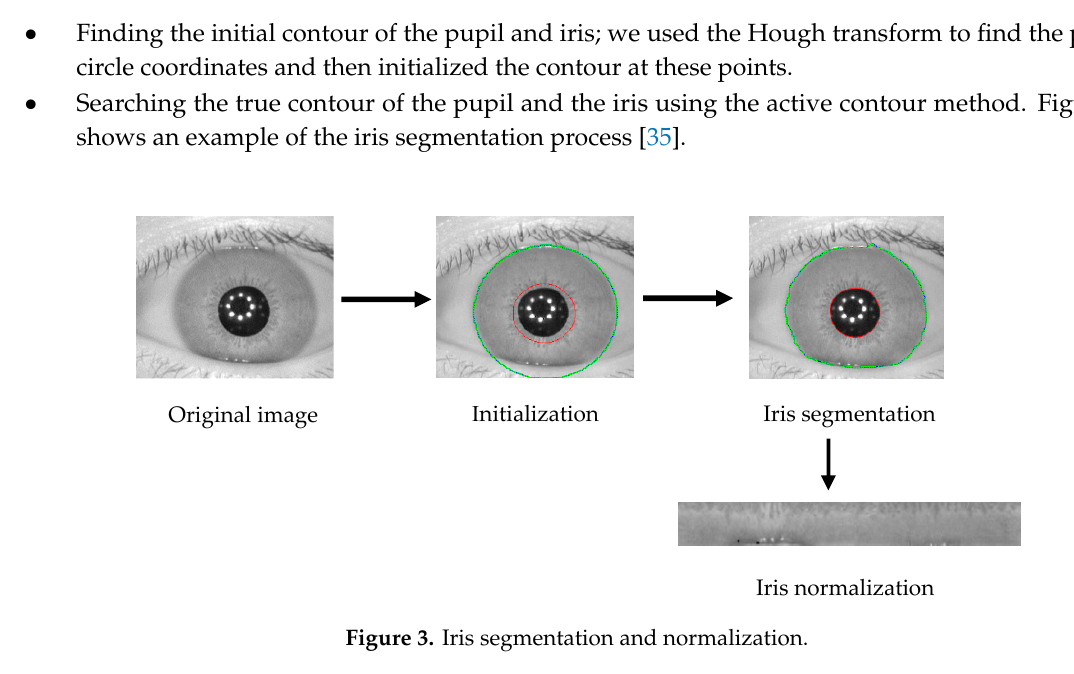
Figure 2. Face detection and preprocessing.